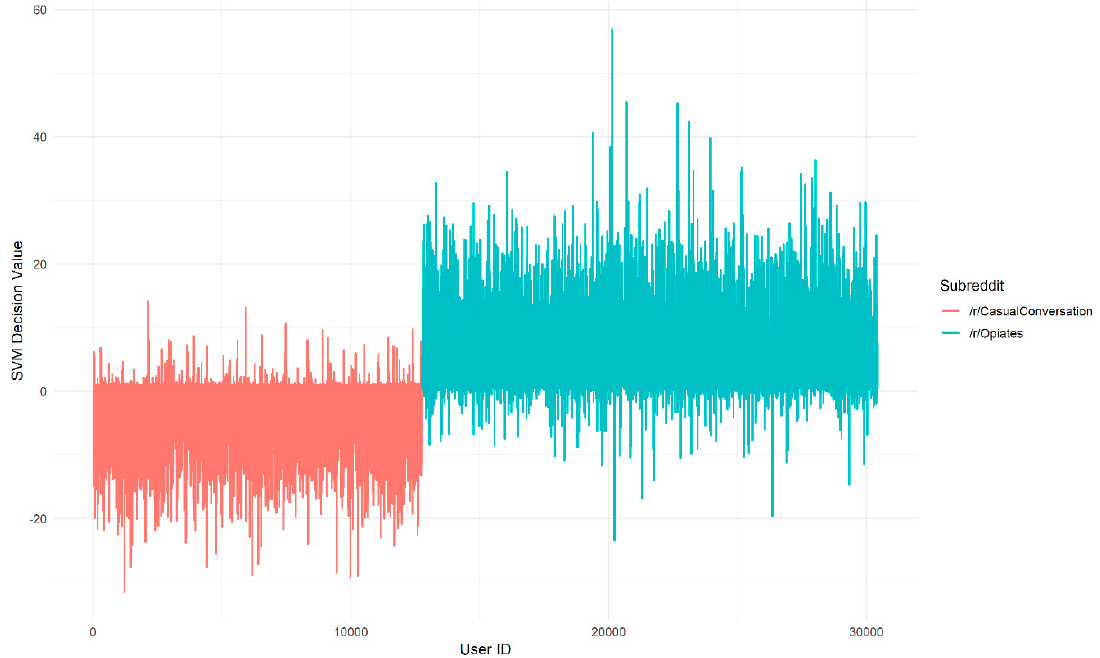
Figure 4. Decision values produced by a Linear SVM for author vectors trained with the Twitter GloVe embedding, colored by subreddit of origin. A large magnitude of decision values corresponds to a large distance from the decision boundary of the SVM. The x-axis is an arbitrary user ID assigned to an author vector from /r/CasualConversation (left) or /r/Opiates (right).